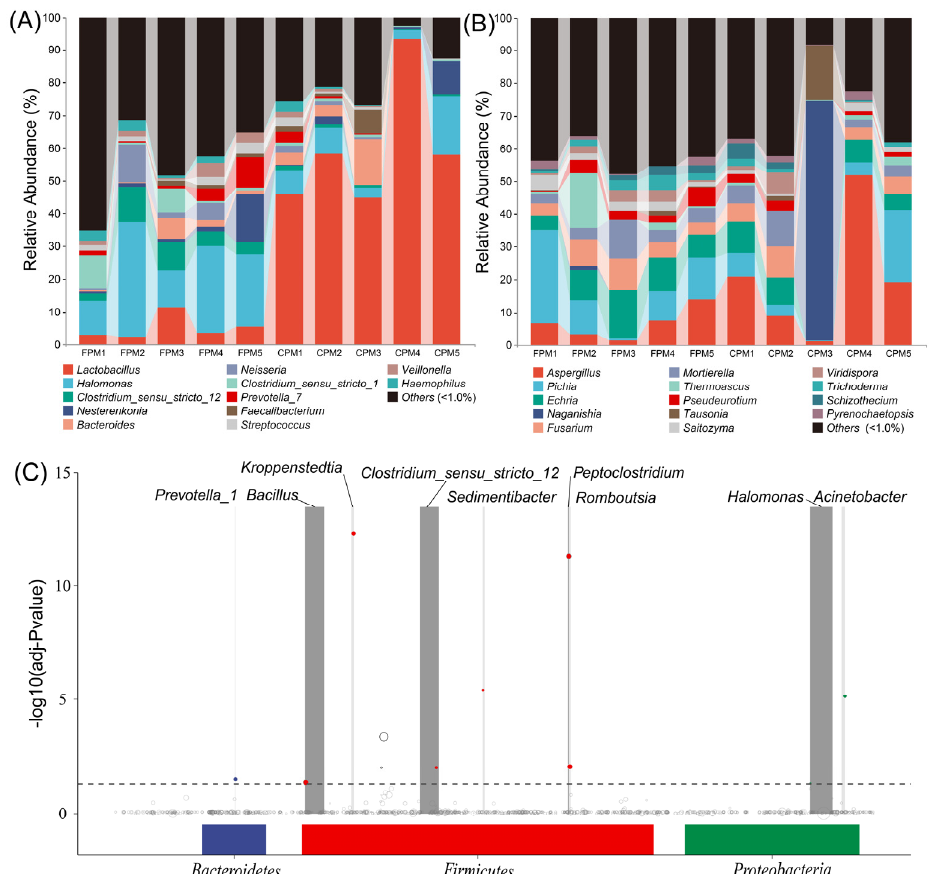
Figure 2. The bacterial ( A ) and fungal ( B ) communities of FPM and CPM at the genus level. The MetagenomeSeq analysis of bacterial community at the amplicon sequence variant (ASV) level, each node represents an ASV ( C ).